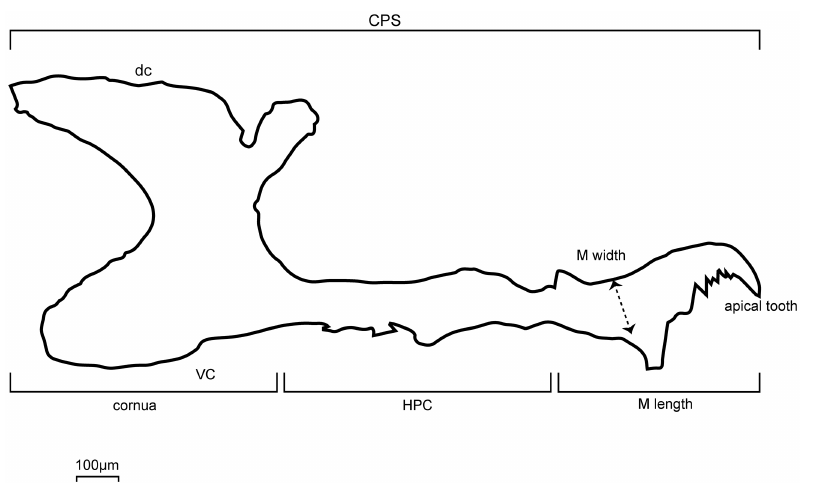
Fig 4. A simplified lateral view of Cephalopharyngeal skeleton CPS of D . gaucha . Hypopharyngeal sclerite and ConuaHPC and MandiblesM are identified;dc, dorsal cornu; vc, ventral cornu. Measurement performed expressedin micrometers ( μ m) are framed. Larvae measuredwere 24, 48, 72, 96, 120, 144, 168 and 196 h old (N = 50 per larval age). HPC and M of larvae of the BA and CJ parentalstrains, reciprocalF1, two out of four F2 and four out of eight backcrosses were measured(N = 4,000 larvae). Mandible teeth numberwas also countedat each larval age. CPS shown corresponds to 96 h old larvae.